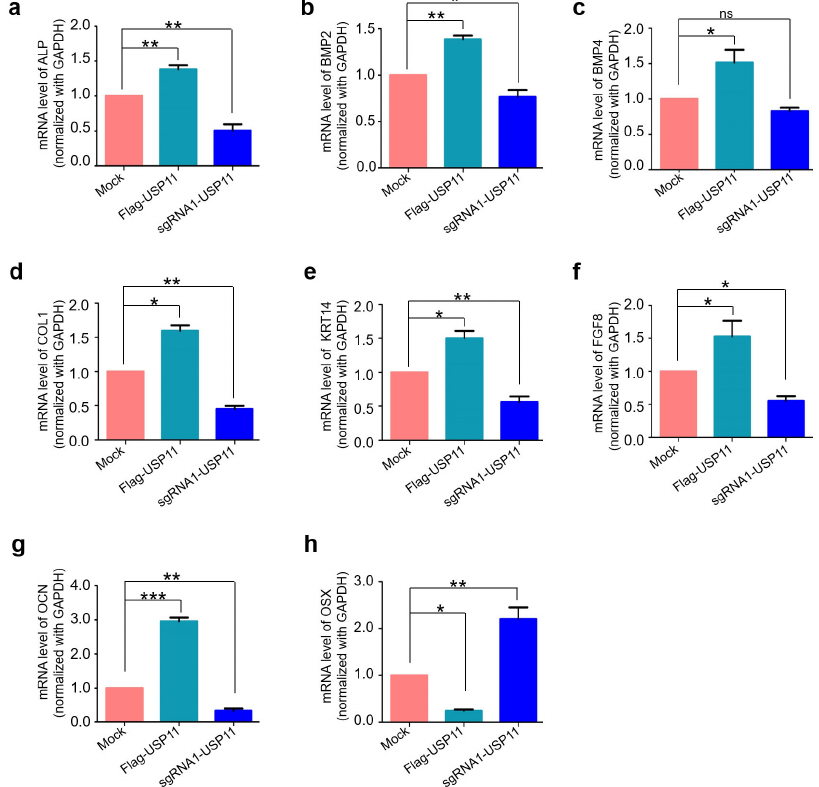
Figure 4. USP11 enhances osteogenic transcriptional factors in hMSCs. The mRNA levels of respective osteogenic markers ( a ) ALP , ( b ) BMP2 , ( c ) BMP4 , ( d ) COL1 , ( e ) KR14 , ( f ) FGF8 , ( g ) OCN , and ( h ) OSX were quantified by qRT-PCR in hMSCs stably expressing Flag-USP11 and hMSCs with sgRNAs targeting USP11 in comparison to a mock control. The average values from three independent experiments are shown. Error bars represent ± SD, ns = non significance, * p < 0.05, ** p < 0.001, and *** p < 0.0001 by ANOVA followed by Tukey’s post hoc